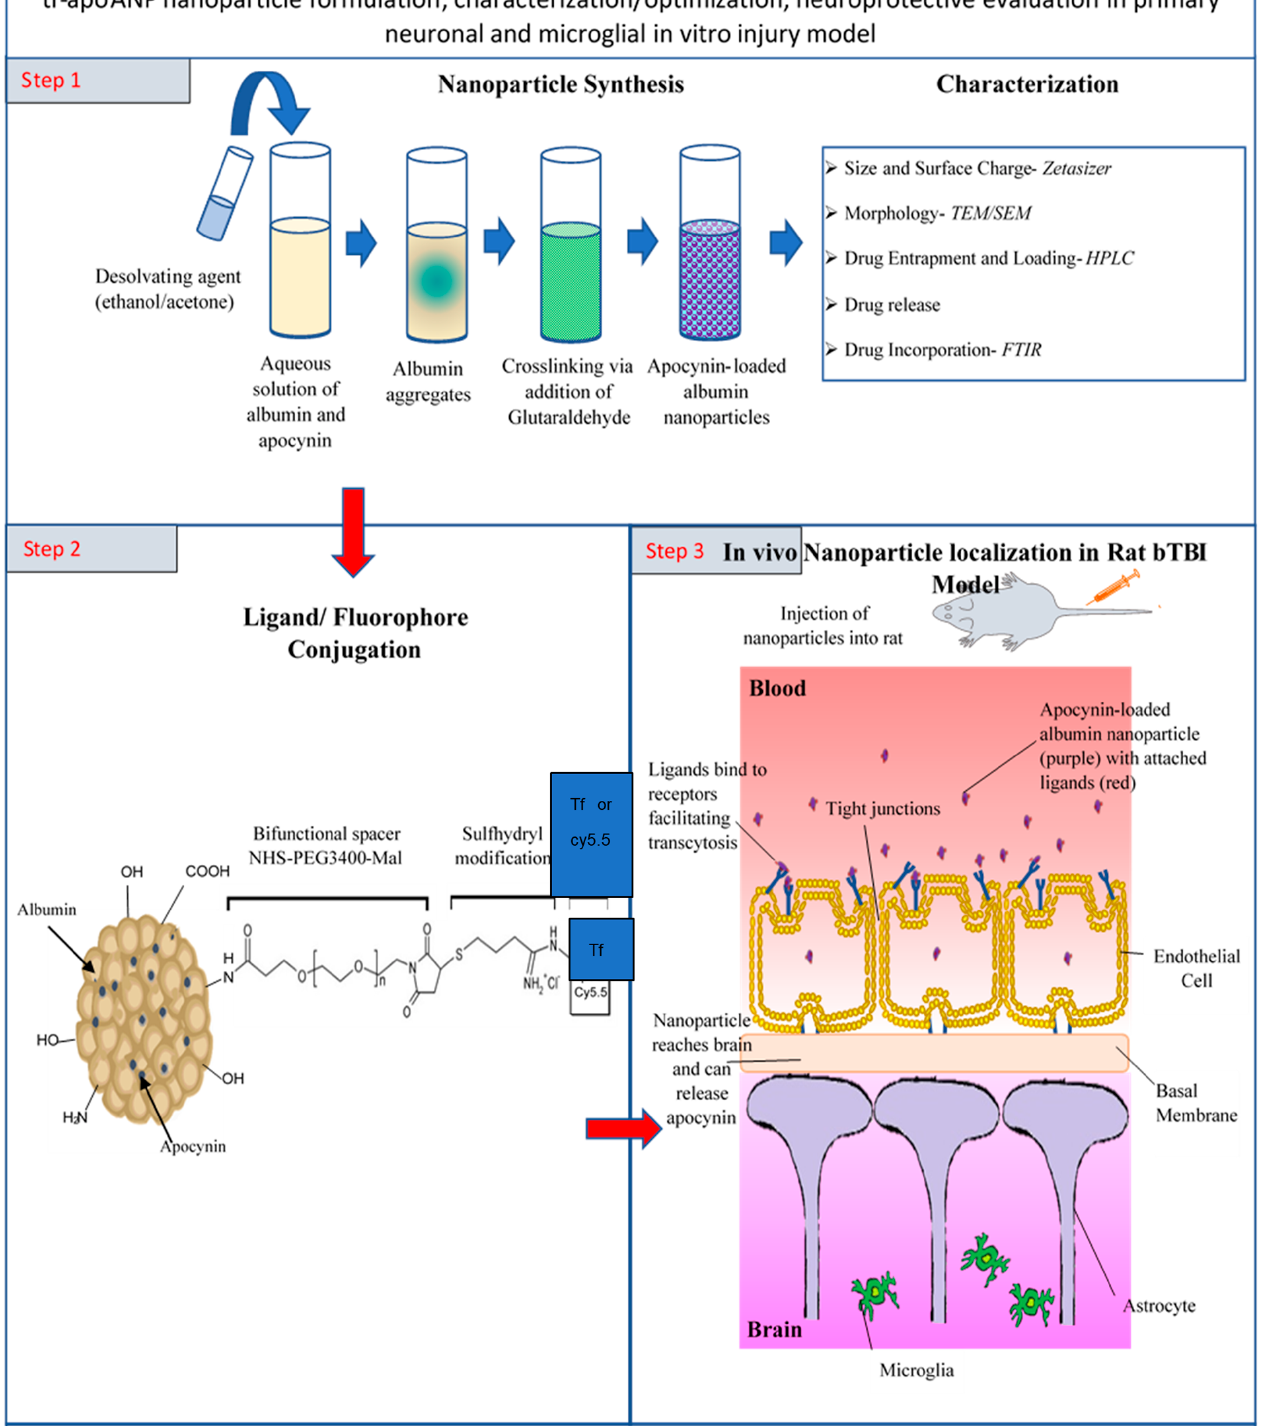
Figure 1. A schematic illustration of apocynin-loaded, TfR-targeted albumin nanoparticle (tf-apoANP) synthesis using the cross-linking method and characterization. Covalent conjugation of transferrin and FITC to BSA nanoparticles. Ligand-conjugated apoANPs can enter the CNS through the impaired BBB and BBB endothelium via receptor-mediated transcytosis.